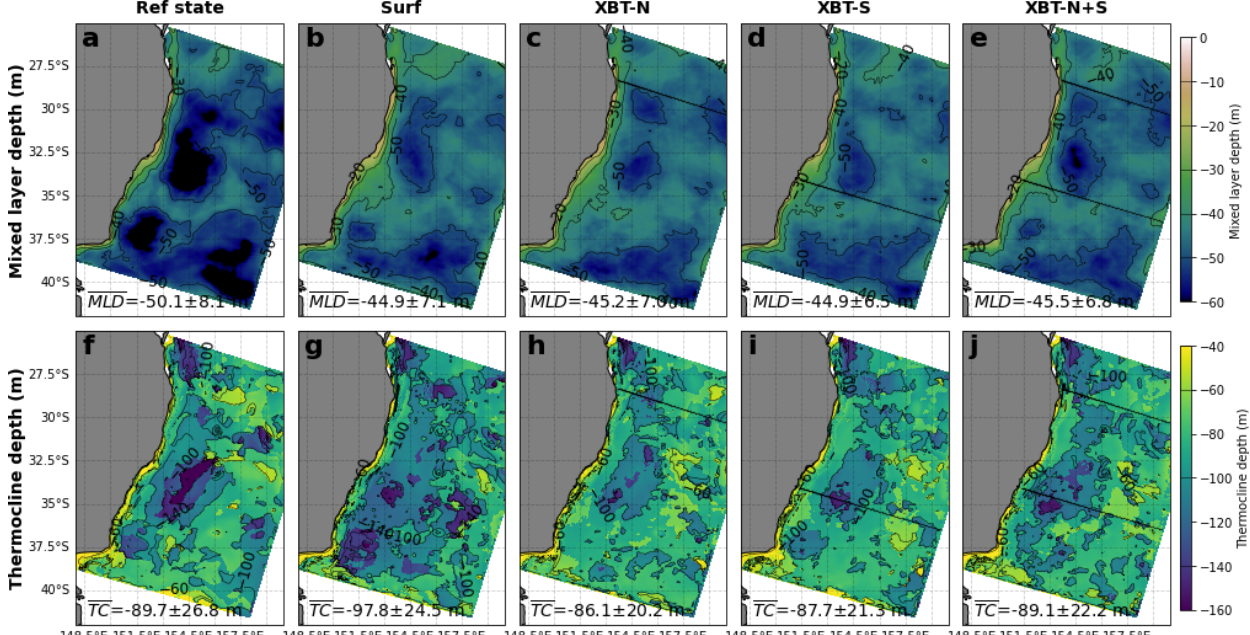
Figure 2. The mean mixed layer depth (first row) is shown for the Ref state (a) and each OSSE (b–e) . The mixed layer depth is calculated as the depth at which temperature is 0.5 ◦ C less than the SST. The thermocline depth (second row) is shown for the Ref state (f) and each OSSE (g–j) . The thermocline depth is calculated as the depth equal to twice the distance from the bottom of the mixed layer to the depth of maximum change in temperature with depth. MLD and TC show the spatial means and standard deviations of the mixed layer and thermocline depth, respectively. The XBT-N and XBT-S transect locations are marked in the respective panels. Axes with latitudes are labelled ◦ S, and axes with longitudes are labelled ◦ E.